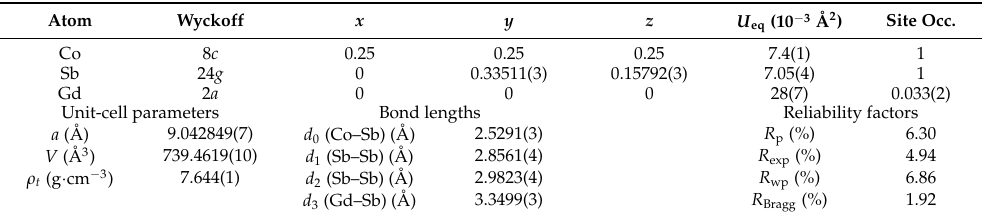
Table 1. Refined structural parameters of the Gd-filled Co 4 Sb 12 skutterudite from SXRD data at room temperature. Abbreviations : U eq is the equivalent mean-square displacement, Site Occ. the site occu- pancy, and 𝜌 (cid:3047) the theoretical density.